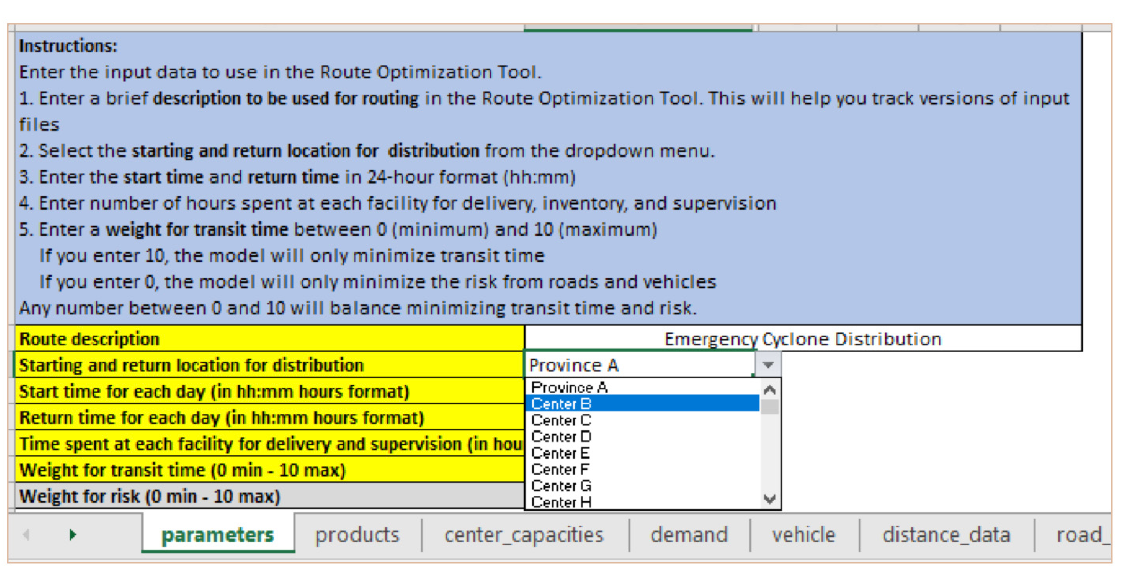
Figure 4. Change the distribution warehouse location from Province A to Center B in the “parameters” input sheet.